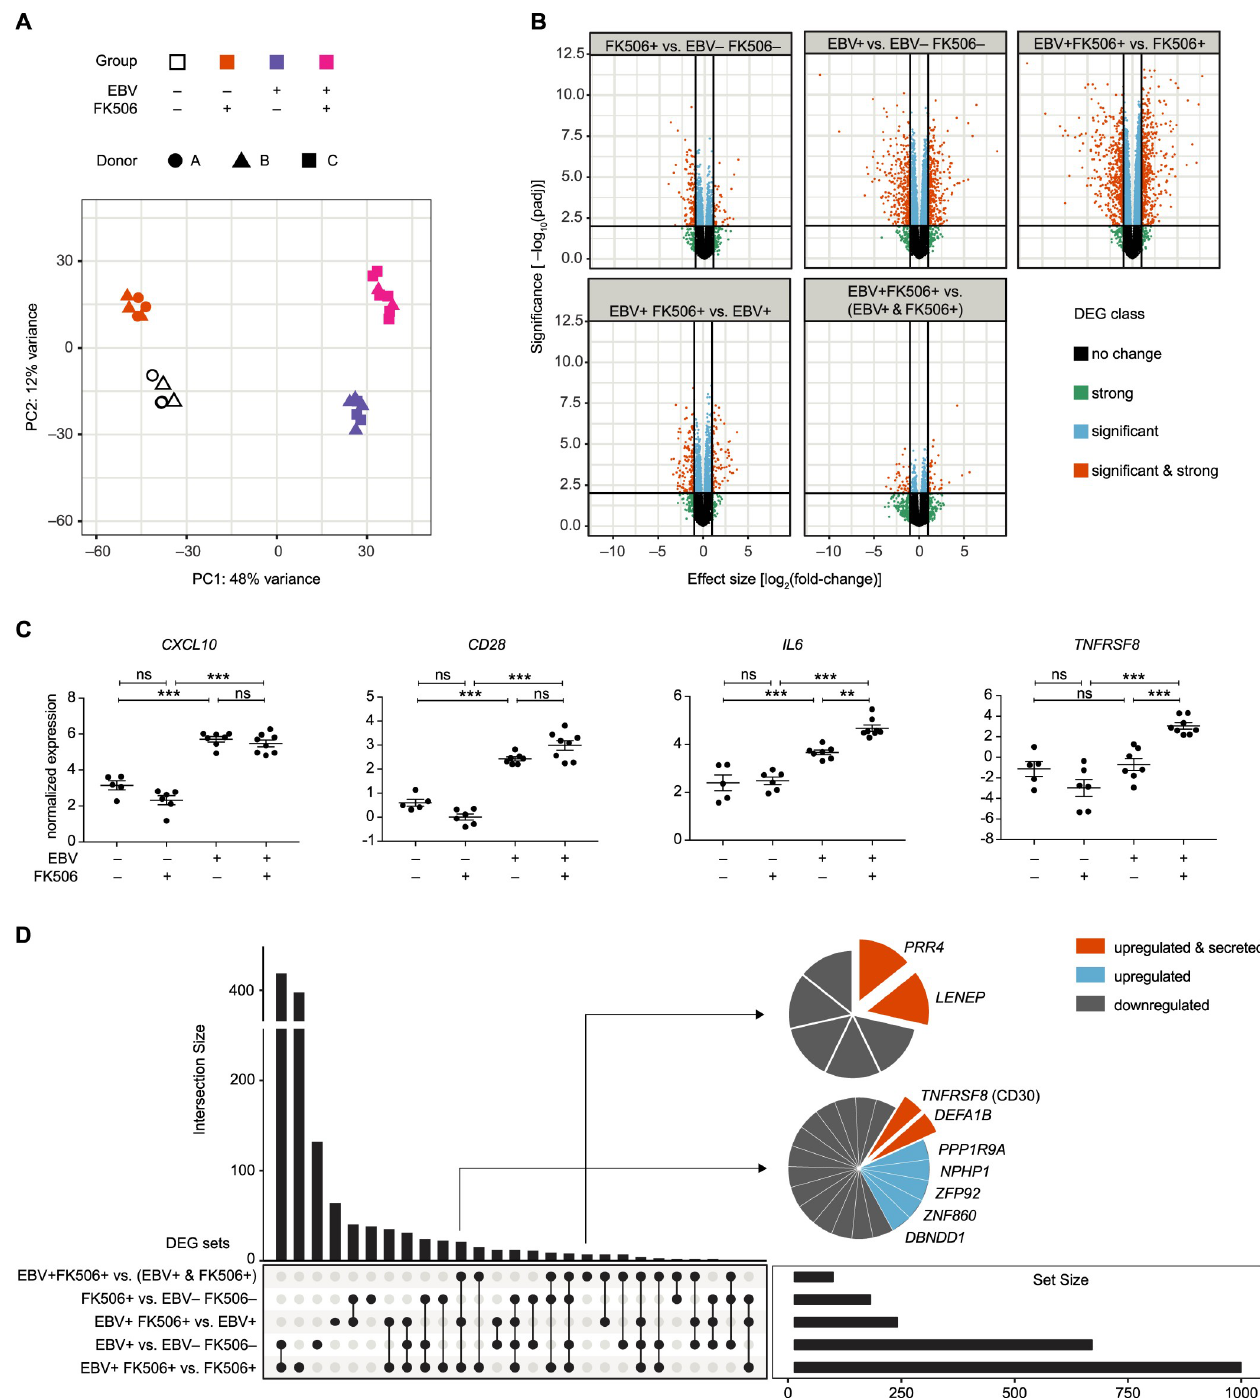
Fig 4. Host transcriptome profiling reveals differential gene expression in B cells of EBV-infected huNSG-A2 mice treated with FK506. A) RNA expression profiling of the human B cell transcriptome of mice from three independent experiments with EBV − FK506 – (n = 5, clear), EBV − FK506 + (n = 6, orange), EBV + FK506 – (n = 7, purple) and EBV + FK506 + (n = 8, magenta). Principal component plot: Sample similarity in a 2D projection by multi- dimensional scaling. Spurious batch effects of unknown origin and HFL donor-specific effects were corrected by surrogate variable analysis. The two principal components represent 60% of the total variance in the data set. B) Volcano plots: The horizontal line corresponds to FDR = 0.01 and genes below this line are labeled ‘not significant’. The two vertical lines correspond to a 2-fold change in expression and genes outside this range are labelled ‘strong’. The legend refers to ‘not’—not significant and weak effect; ‘signif & strong’—significant and strong effect; ‘signif’—significant but weak effect; ‘strong’—not